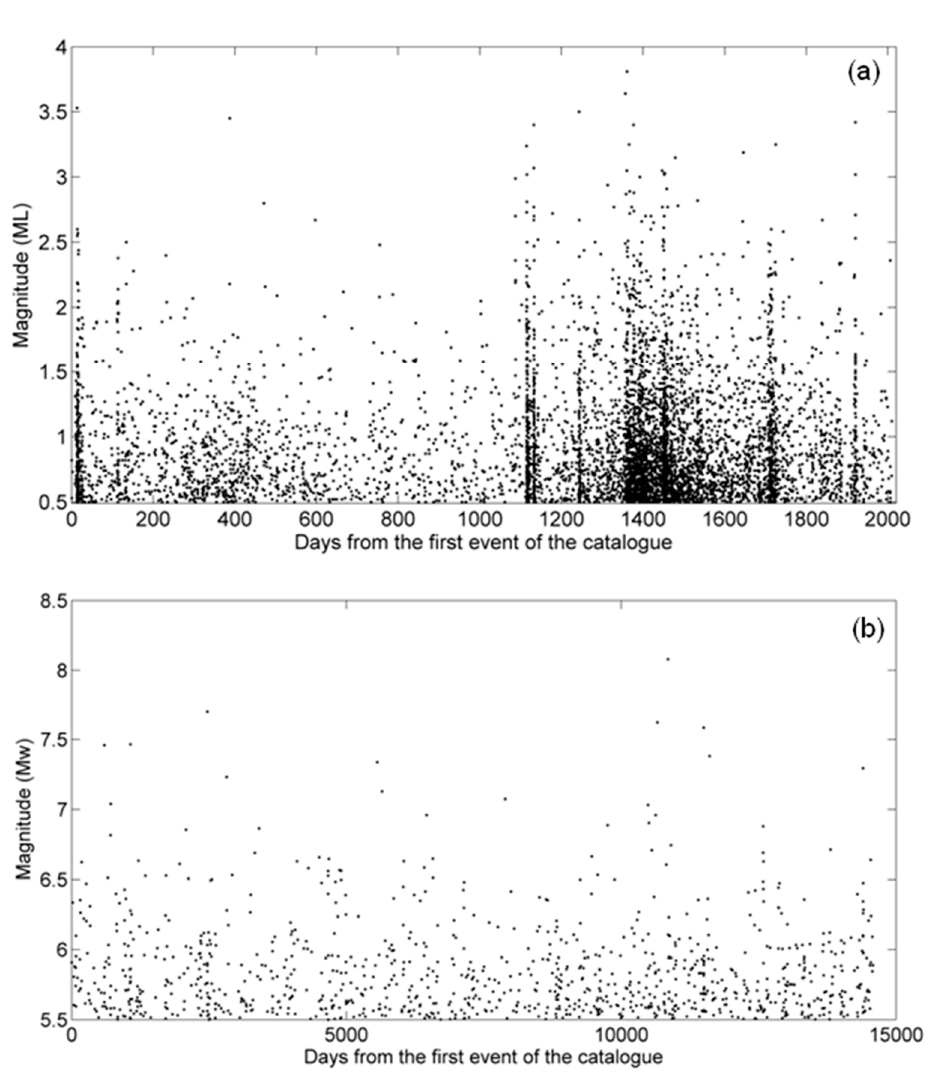
Figure 2. Time vs magnitude plot of the TABOO ( a ) and CMT ( b ) catalogues.